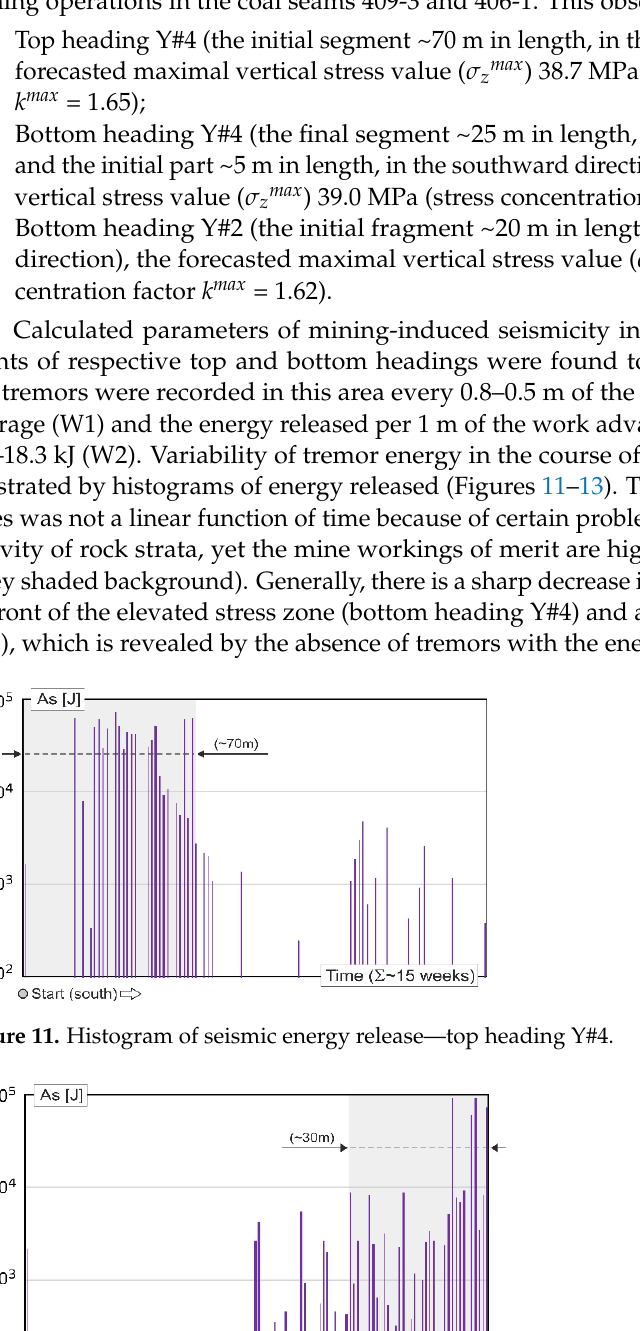
Figure 13. Histogram of seismic energy release — bottom heading Y#2. It is interesting that the stress concentration zones determined by analytical methods were to be attributed to impacts of the mining edge in a nearby (6 – 19 m) seam 409-3, which was not verified in the course of repeated in situ tests. During the drifting opera- tions, there were over 700 small-diameter bores that were drilled ( ∅ 42 mm, up to 12 m in length) in the coal seam, revealing no critical yield of cuttings (6 dm 3 /m). The results of seismoacoustic observations also proved ineffective, 99.5% of them reporting no danger. Yet the technical problem experienced during the mining operations was suggestive of the presence of a zone with unfavourable stress conditions whilst the registered (low-energy) seismic activity indicated the critical state of stress in coal or in the imme- diate roof or floor strata. Thus, the presented forecast provided an additional (and per- haps the most significant) criterion for the mine operators to rely on when selecting and implementing the rockburst control measures. In regards to the rockburst protection measures, it appears that the type and extent of deployed control measures were fully adequate to match the hazard levels forecasted and recorded at subsequent stages of the roadheading operation. However, the effec- tiveness of adopted active control measures (blasting operations, see Table 3) considered in the quantitative analysis of all recorded seismic events (in all energy categories) was found to not be fully satisfactory, averaging 16.5%. One has to bear in mind, however,